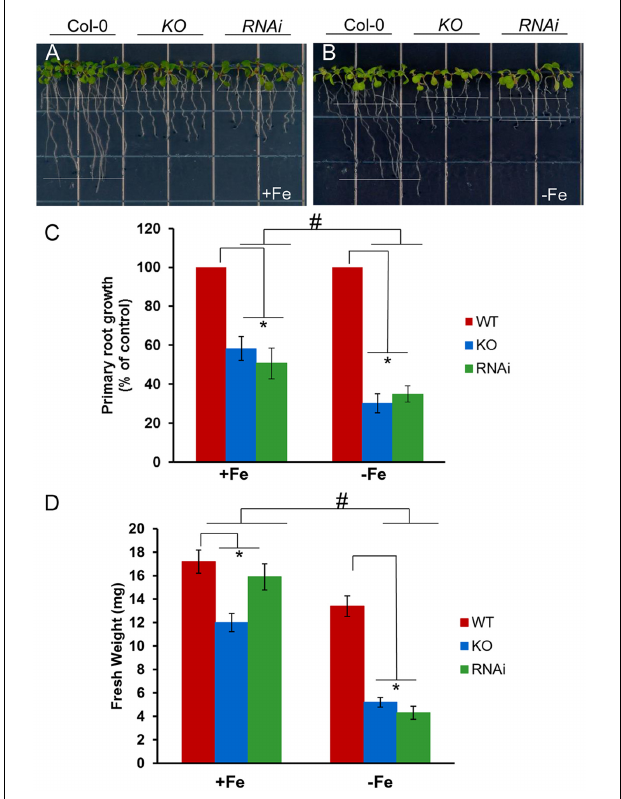
FIGURE 2 | Loss of AtGRXS17 impairs seedlings growth under iron deficiency stress. (A–C) , Wild type control, atgrxs17 KO, and AtGRXS17 RNAi seeds were germinated and grown on 1 / 2 MS medium (0.5% Sucrose) for 5 days and then transferred onto Fe sufficient or deficient medium as indicated for 6 additional days of growth at 22 ◦ C. In (C) , primary root growth was measured and the growth rate was calculated relative to wild type controls. Statistical analysis using a two-way ANOVA. n ≥ 18. ∗ p < 0.05, significance between WT controls and atgrxs17 mutants; # p < 0.05, significance between +Fe and –Fe treatments. (D) Wild type control, atgrxs17 KO, and AtGRXS17 RNAi seeds were germinated on 1 / 2 MS medium (0.5% Suc) for 5 days and then transferred onto iron sufficient or deficient medium as indicated for 11 days of growth at 22 ◦ C. Fresh weight was measured to compare mutants to wild type controls. Statistical analysis using a two-way ANOVA. n ≥ 12. ∗ p < 0.05, significance between WT controls and atgrxs17 mutants; # p < 0.05, significance between +Fe and –Fe